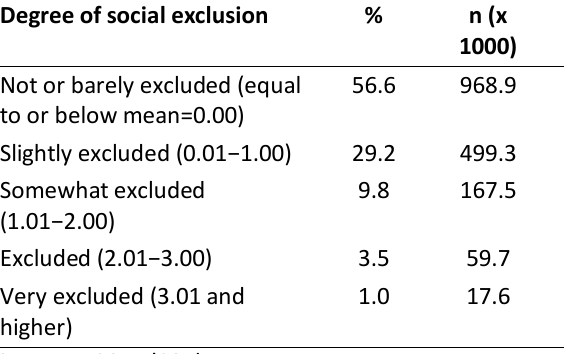
Table 3. Prevalence of social exclusion among Dutch children, 2008 (in percentages and absolute numbers; general index, weighted